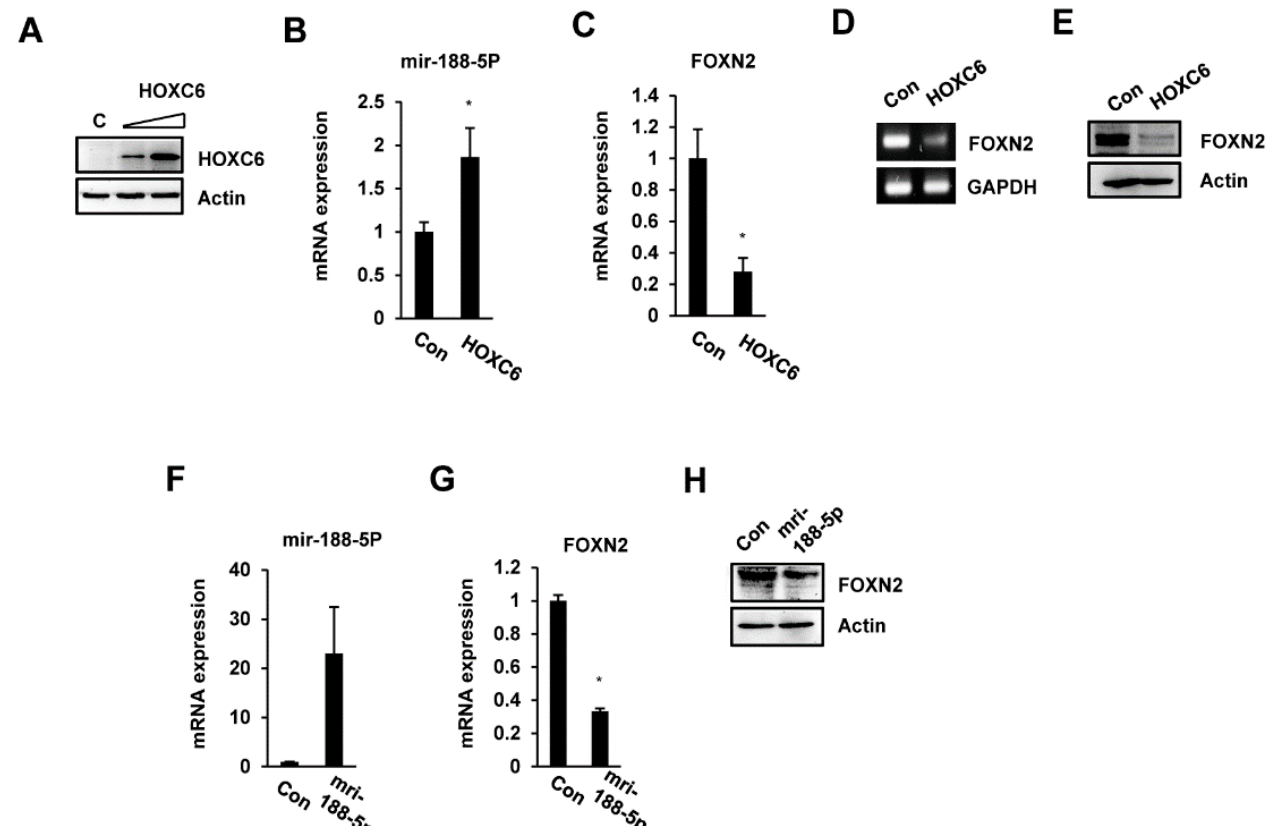
Figure 4. Effects of HOXC6 or miR-188-5p on FOXN2 expression in HEK293 cells. Cells were transfected with pcDNA3-HOXC6 for 48 h. ( A , B ) HOXC6 or miR-188-5p was analyzed by Western blotting or quantitative RT-PCR in FaDu/HOXC6 cells. ( C – E ) Expression of FOXN2 mRNA and protein in HOXC6- or miR-188-5p mimic-expressing HEK293 cells. The qRT-PCR data are presented as the mean ± SD from three independent experiments. * p < 0.05. ( F , G ) HEK293 cells were transfected with pSuper/miR-188-5p for 48 h. miR-188-5p and FOXN2 mRNA expression levels were quantified by qRT-PCR analysis. * p < 0.05 vs. control. ( H ) Total proteins were subjected to Western blotting analysis using FOXN2 antibody. β -actin was used as loading control for Western blot. FOXN2 mRNA and mir-188-5p expression were determined by qRT-PCR, with GAPDH and U6 snRNA serving as an internal control, respectively. Moreover, GAPDH was used as an internal for RT-PCR.